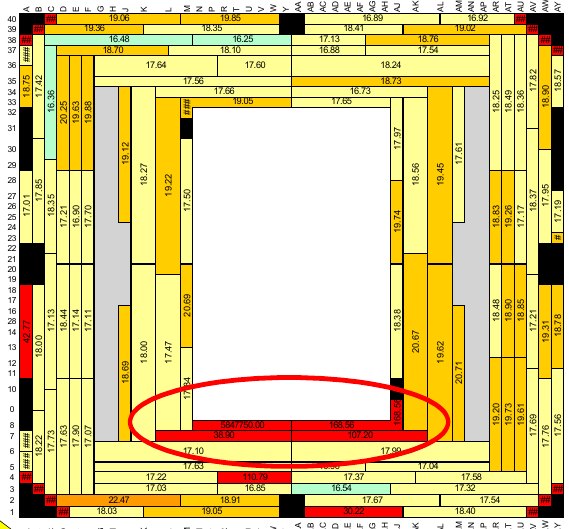
Figure 9. Example of temperature - humidity (TH) open failure.